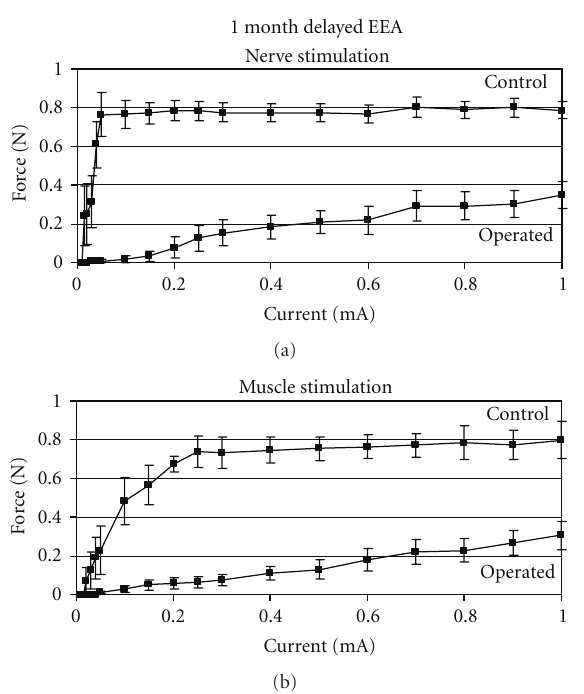
Figure 7: Force-current characteristics of the SM muscle in the 3- month delay EEA group. Muscle force in the operated and control SM muscles was produced by nerve stimulation (a) or by direct muscle stimulation